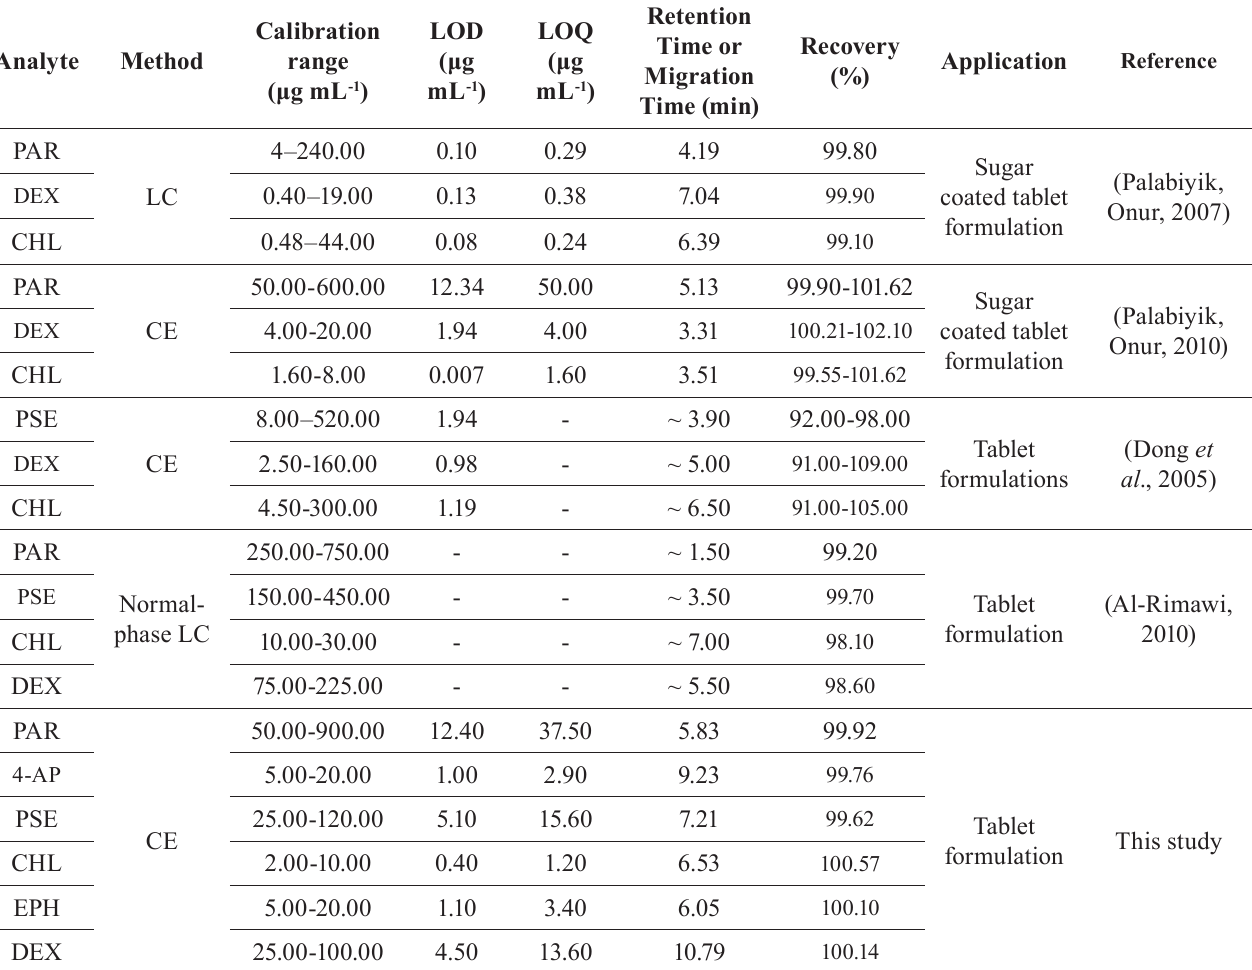
Table IV - Comparison of proposed method with other methods for the determination of PAR, PSE, DEX, CHL, 4-AP and EPH